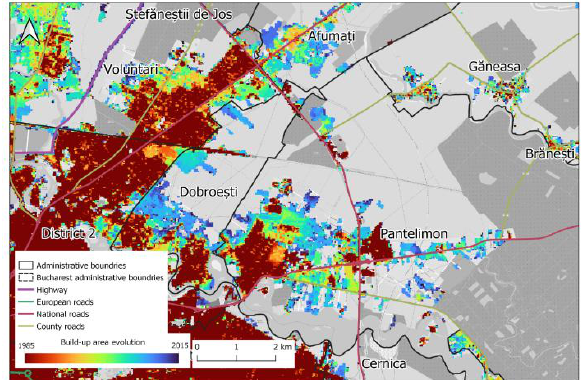
Figure 12 . Urban expansion of Bucharest between 1985 and 2015 - East (data source: WSF Evolution, DLR, CC-BY 4.0; base map: © OpenStreetMap contributors)